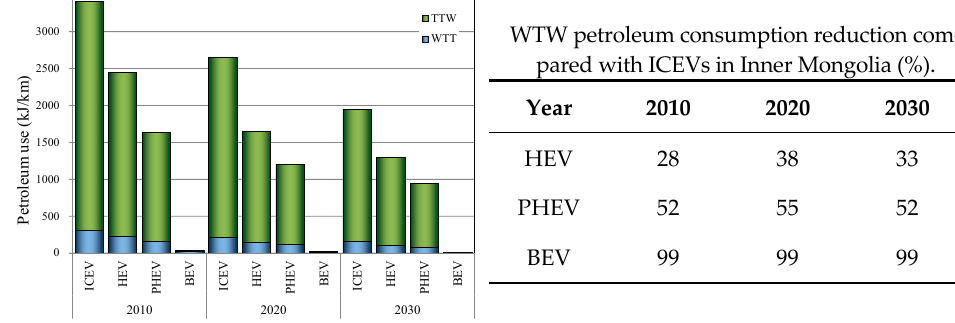
Figure 5. WTW petroleum consumption of ICEVs/HEVs/PHEVs/BEVs in Inner Mongolia. WTW petroleum consumption reduction com- pared with ICEVs in Sichuan (%).